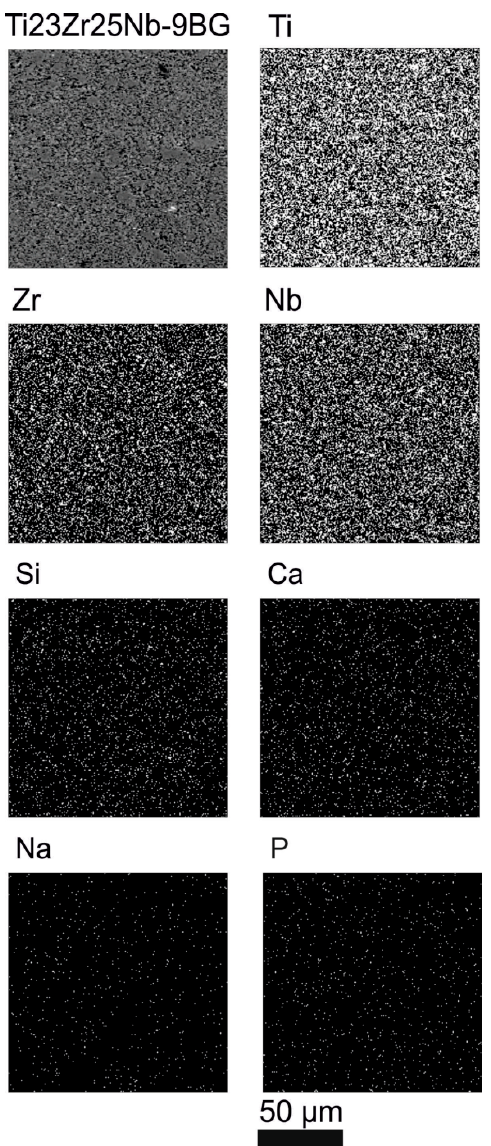
Figure 7. Energy-Dispersive Spectroscopy (EDS) maps of Ti, Nb, Zr, Si, Ca, Na in the Ti23Zr25Nb-based composite with the 9 wt.% 45S5 Bioglass content and within the area of the scan micrograph.